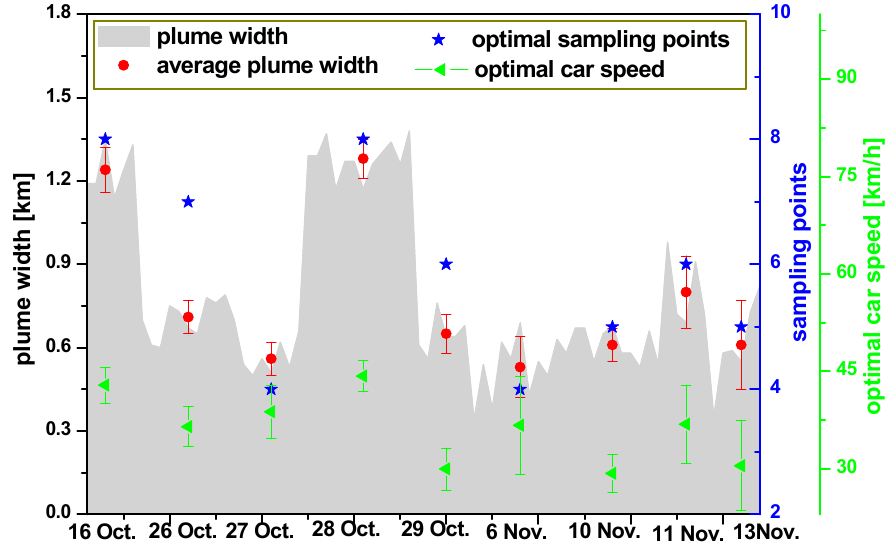
Figure 5. Plume width, average plume width, optimal sampling, and speed.